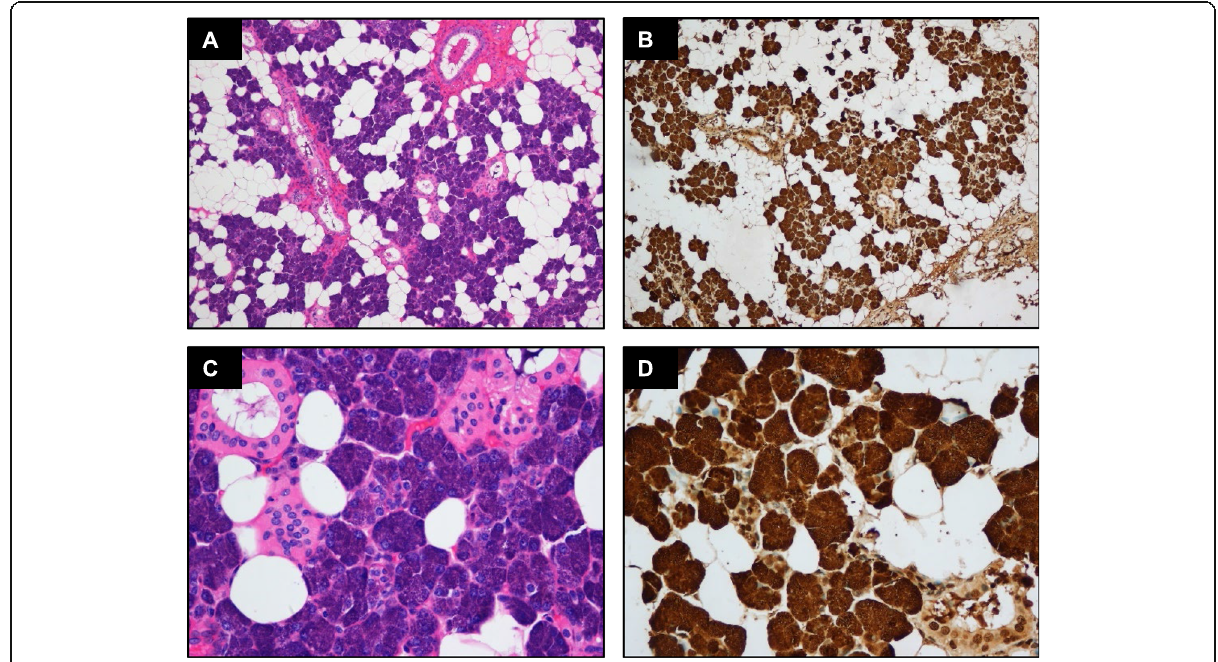
Fig. 1 ( A ) Histology of normal salivary gland tissue. ( B ) The normal serous acinar cells of the salivary gland shows strong and diffuse cytoplasmic staining of LMO2. ( C - D ) Higher power view